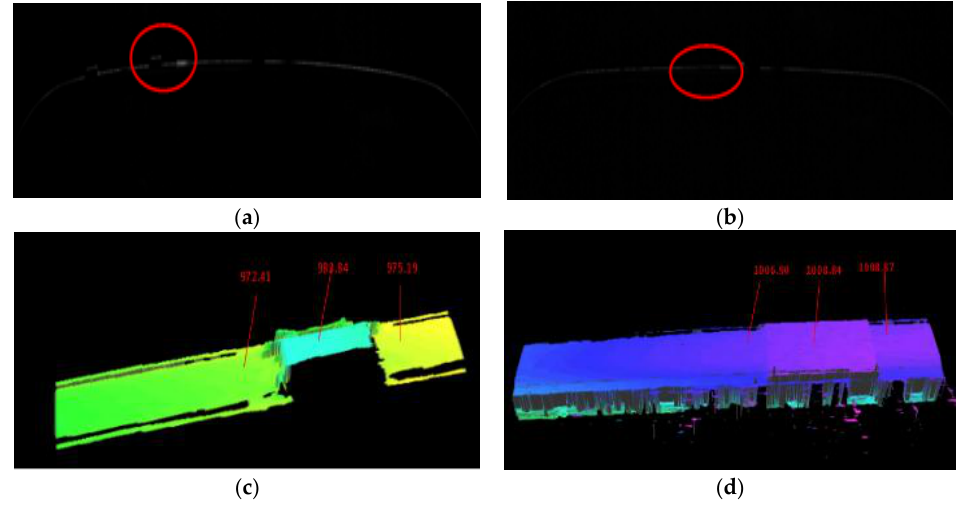
Figure 12. ( a ) 2D Data of Object 1; ( b ) 2D Data of Object 2; ( c ) 3D Data of Object 1; ( d ) 3D Data of Object 2.